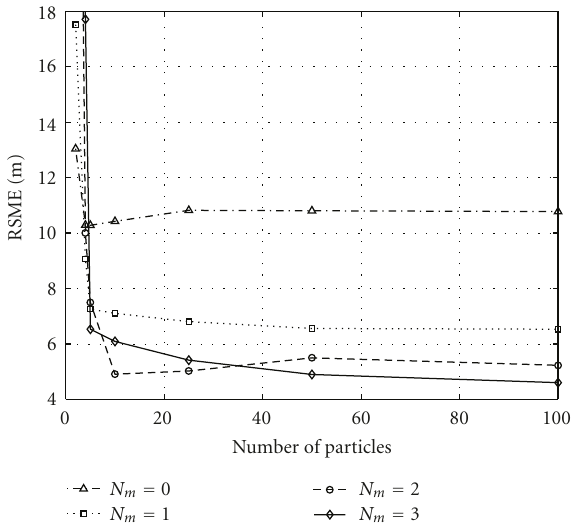
Figure 5: RMSE of LOS estimate as a function of the employed number of particles N p and the number of considered paths N m . Only few particles ( N p < 50) are needed to attain